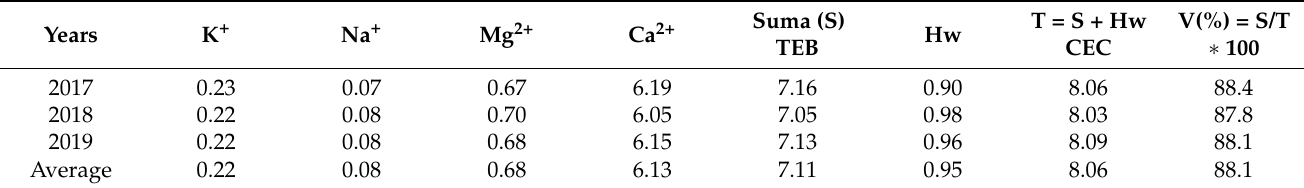
Table 2. Sorption capacity cmol (+) kg − 1